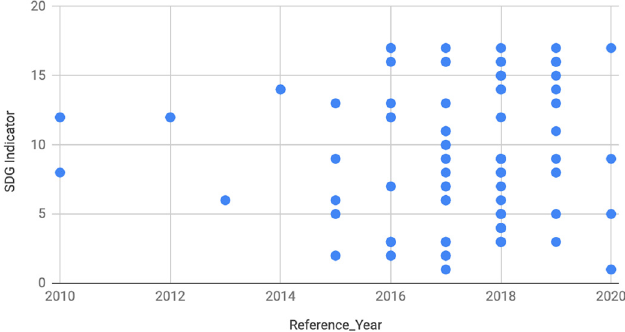
Fig. 4. Scatter chart shows a signi fi cant amount of data is available before 2018.